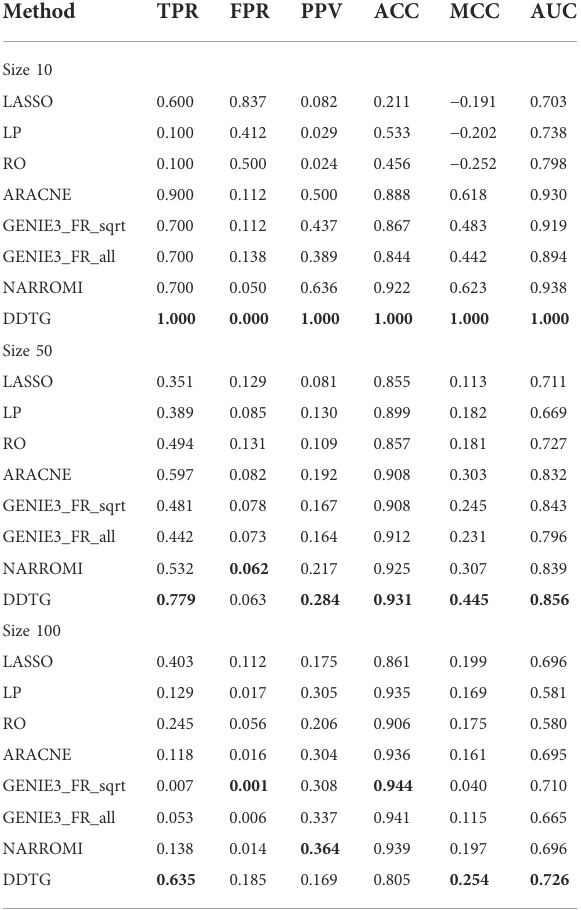
TABLE 1 Comparison on networks with sizes 10, 50, and 100.